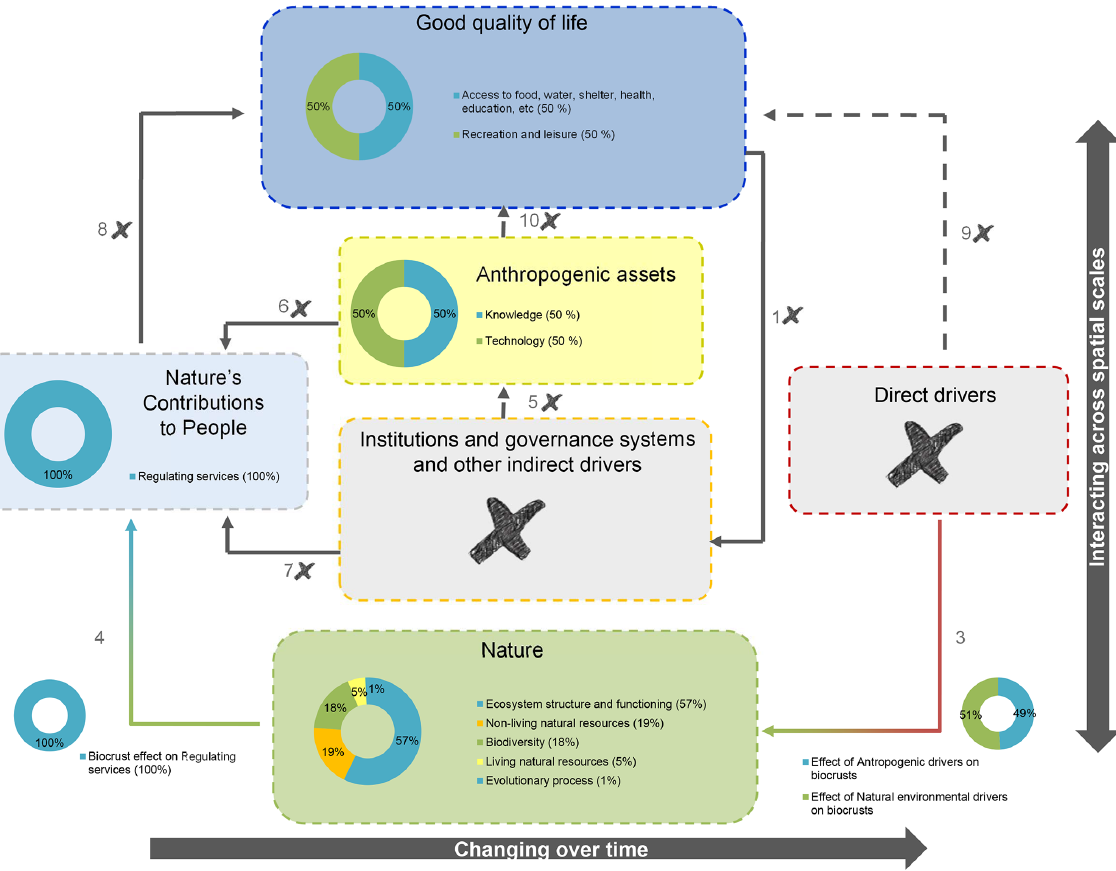
Figure 2. Distribution of biocrust research efforts across the IPBES conceptual framework. Percentage of associations between the knowl- edge generated in each article and the different elements (six categorized components and 10 linkages among them). The main components are represented by boxes whereas lines represent the linkages among them. The percentage of associations is represented by categories within each element and indicated by the area of the pie chart. Crosses indicate knowledge gaps. Figure adapted from Díaz et al.